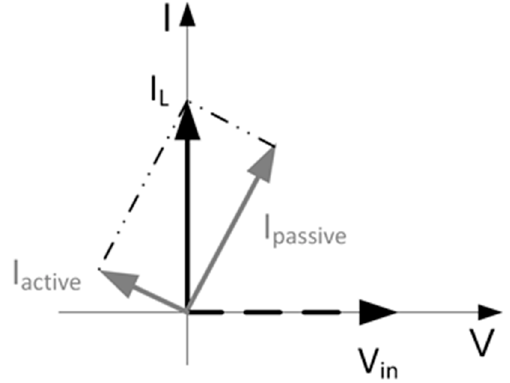
Figure 5. Phasors of voltages and currents in the AI of Figure 3 in the complex plane. V in is the input voltage, I L the current through the inductor L. I passive is the current through the capacitor C g and I active the current drawn from the transistor through the phase-shifting network. Their vectorial sum gives the current through the inductance I L .